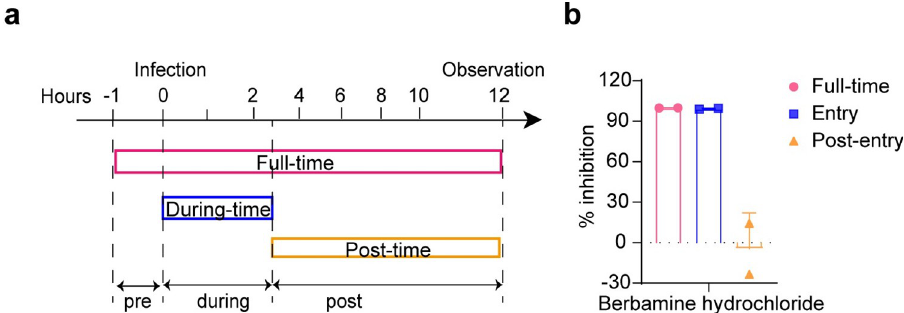
Fig 2. Time-of-addition analysis. (a) The schematic diagram of time-of addition. Approximately 8 × 10 4 Vero-E6 cells were seeded per well of a 24-well plate. After incubation for 24 h, the cells were infected with the SARS-CoV-2 virus at an MOI of 0.05. Berbamine hydrochloride was added to the infected cells at a final concentration of 10 μ M at indicated time points. At 12 h p.i., the cell culture fluids were harvested for qRT-PCR assay (b). Data was expressed as mean ± standard deviation and shown are representative results of two independent experiments with two technical replicas per experiment. Error bars represents standard